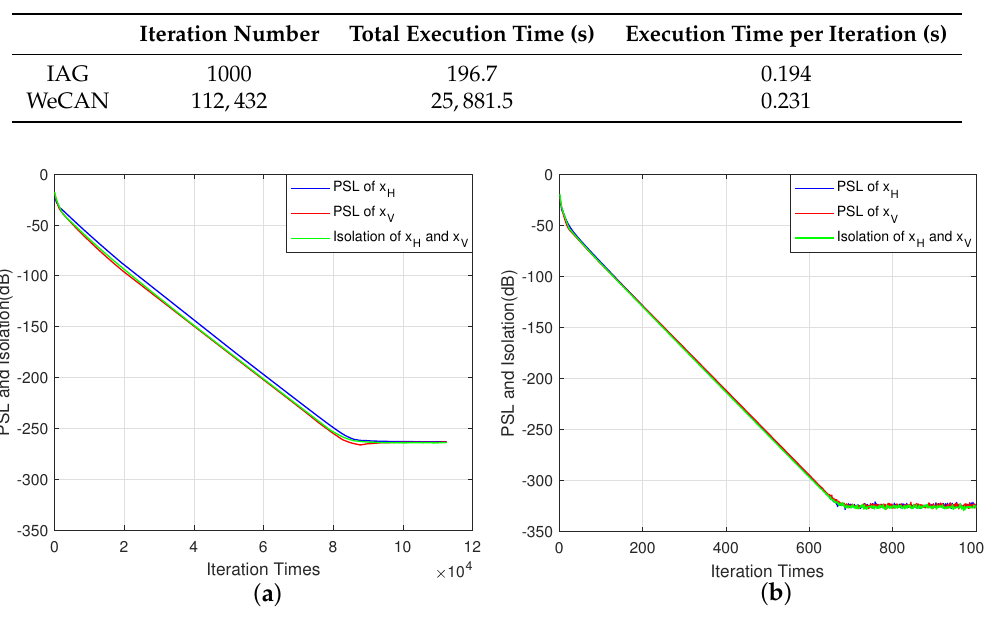
Table 4. Comparison between IAG and WeCAN.